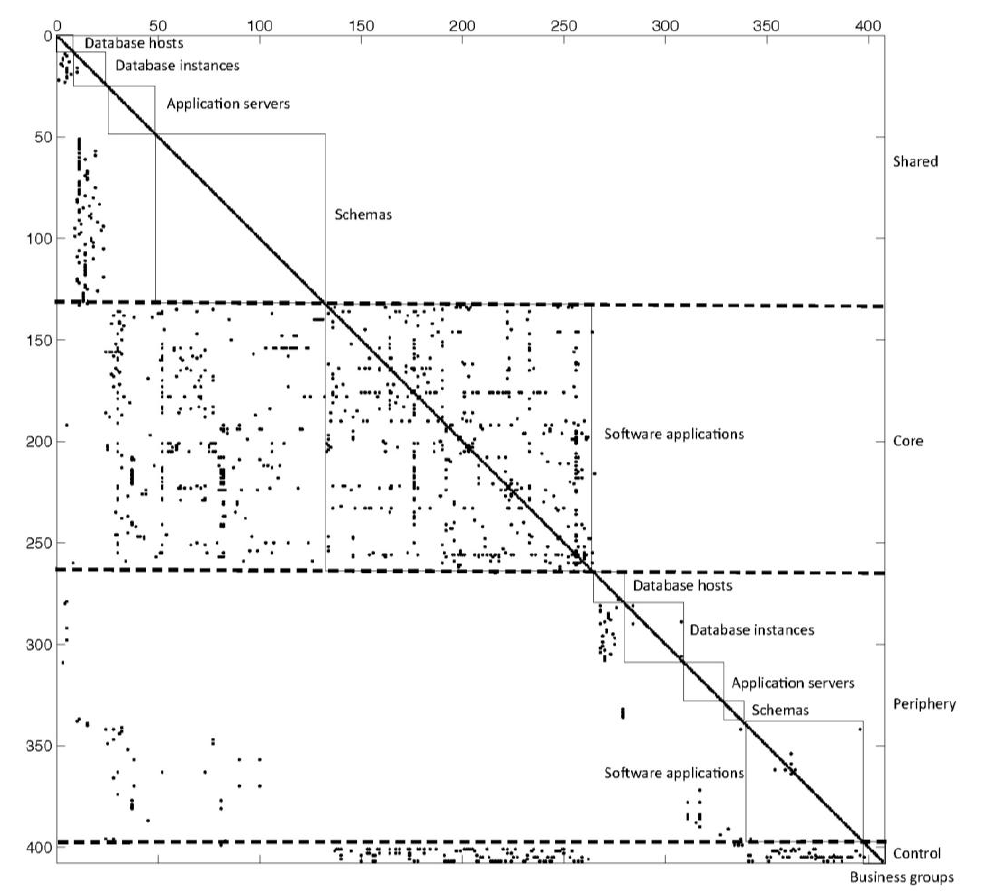
Figure 2. Reorganized DSM showing Main Flow and Peripheral